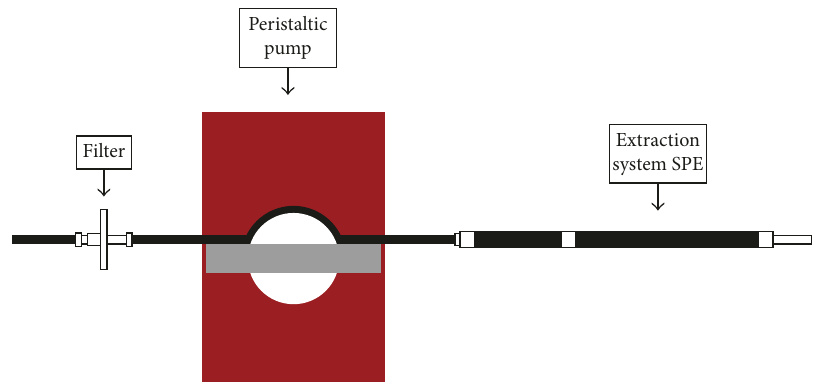
Figure 1: Miniaturised solid phase extraction system